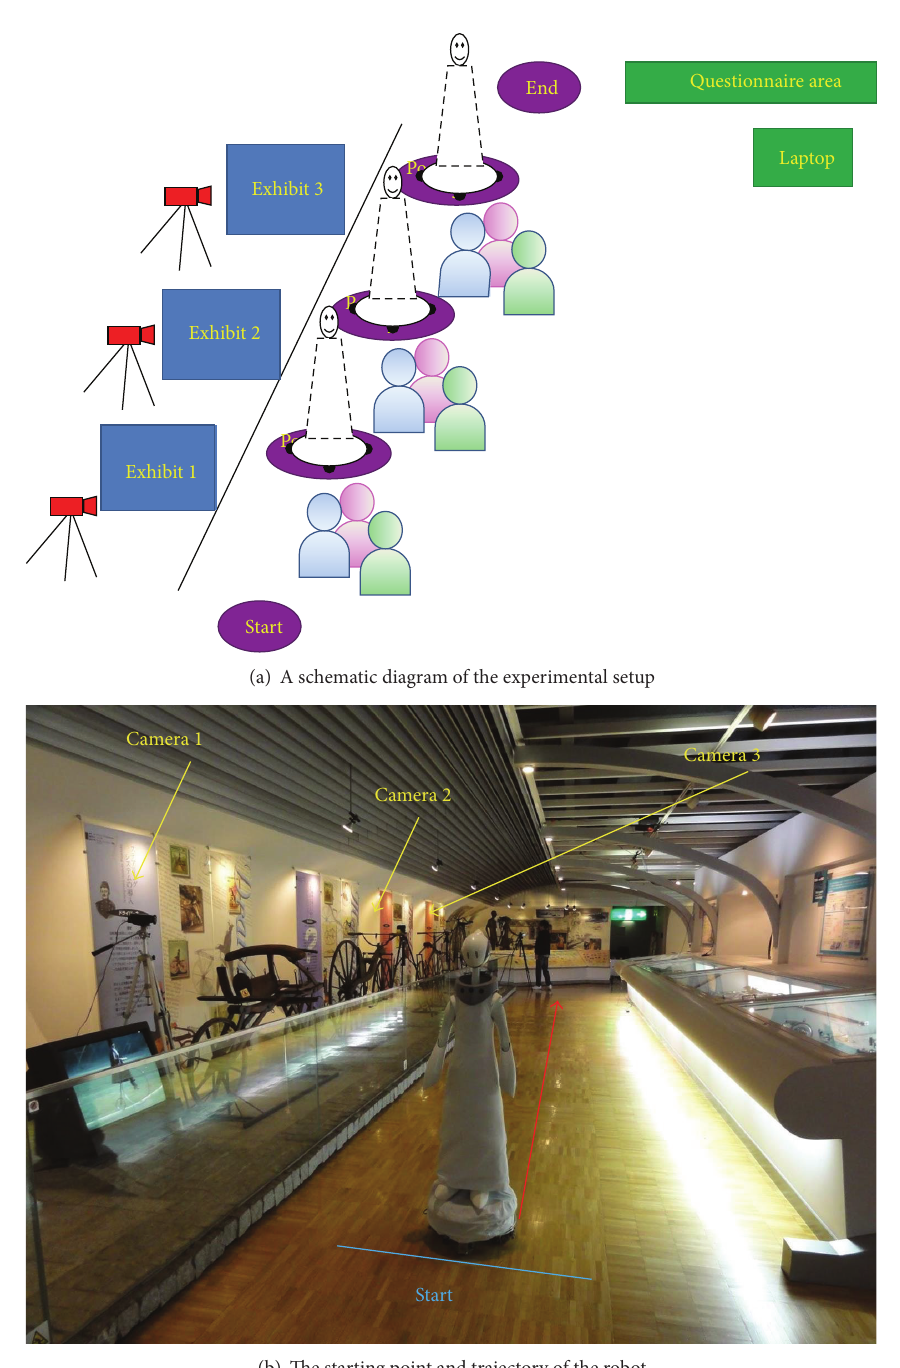
Figure 6: The experimental setup, the actual scene of the